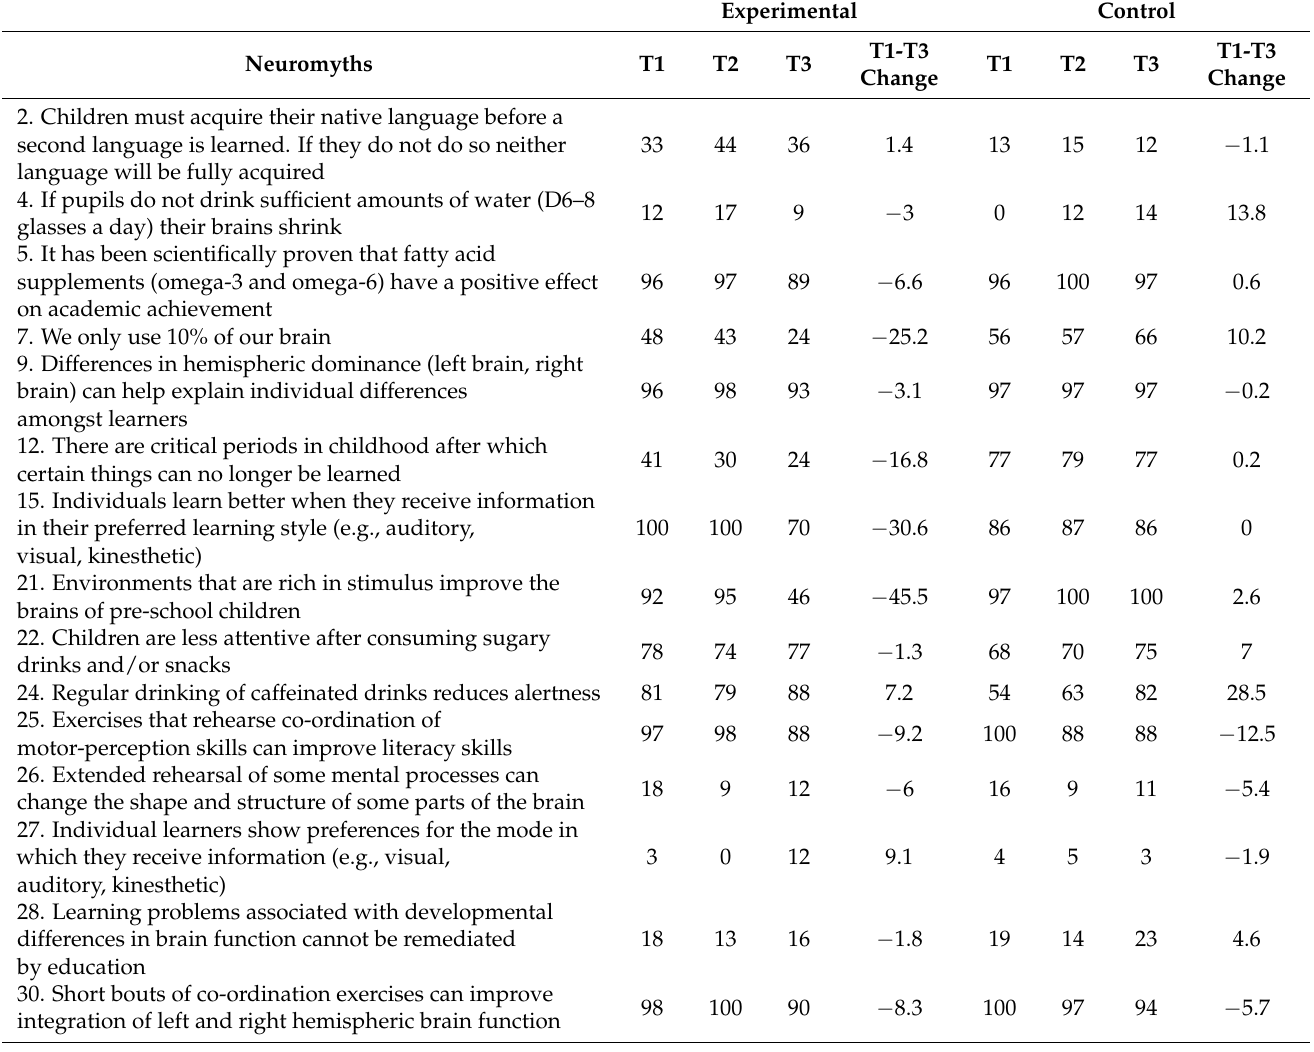
Table 2. Percent beliefs in each neuromyth in the experimental and control groups at Times 1, 2, and